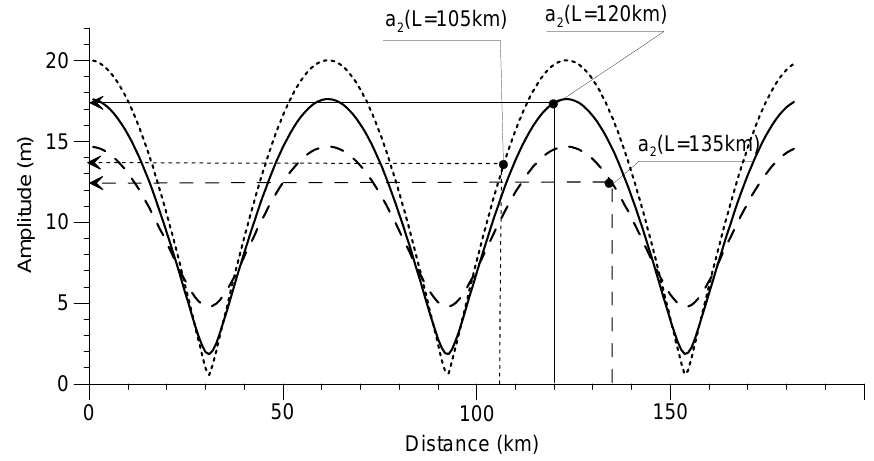
Fig. 14. Wave amplitudes of the second baroclinic mode generated by a two-sill topography as a function of the distance between the sills. Solid, dashed and dotted lines correspond to similar curves in Fig.